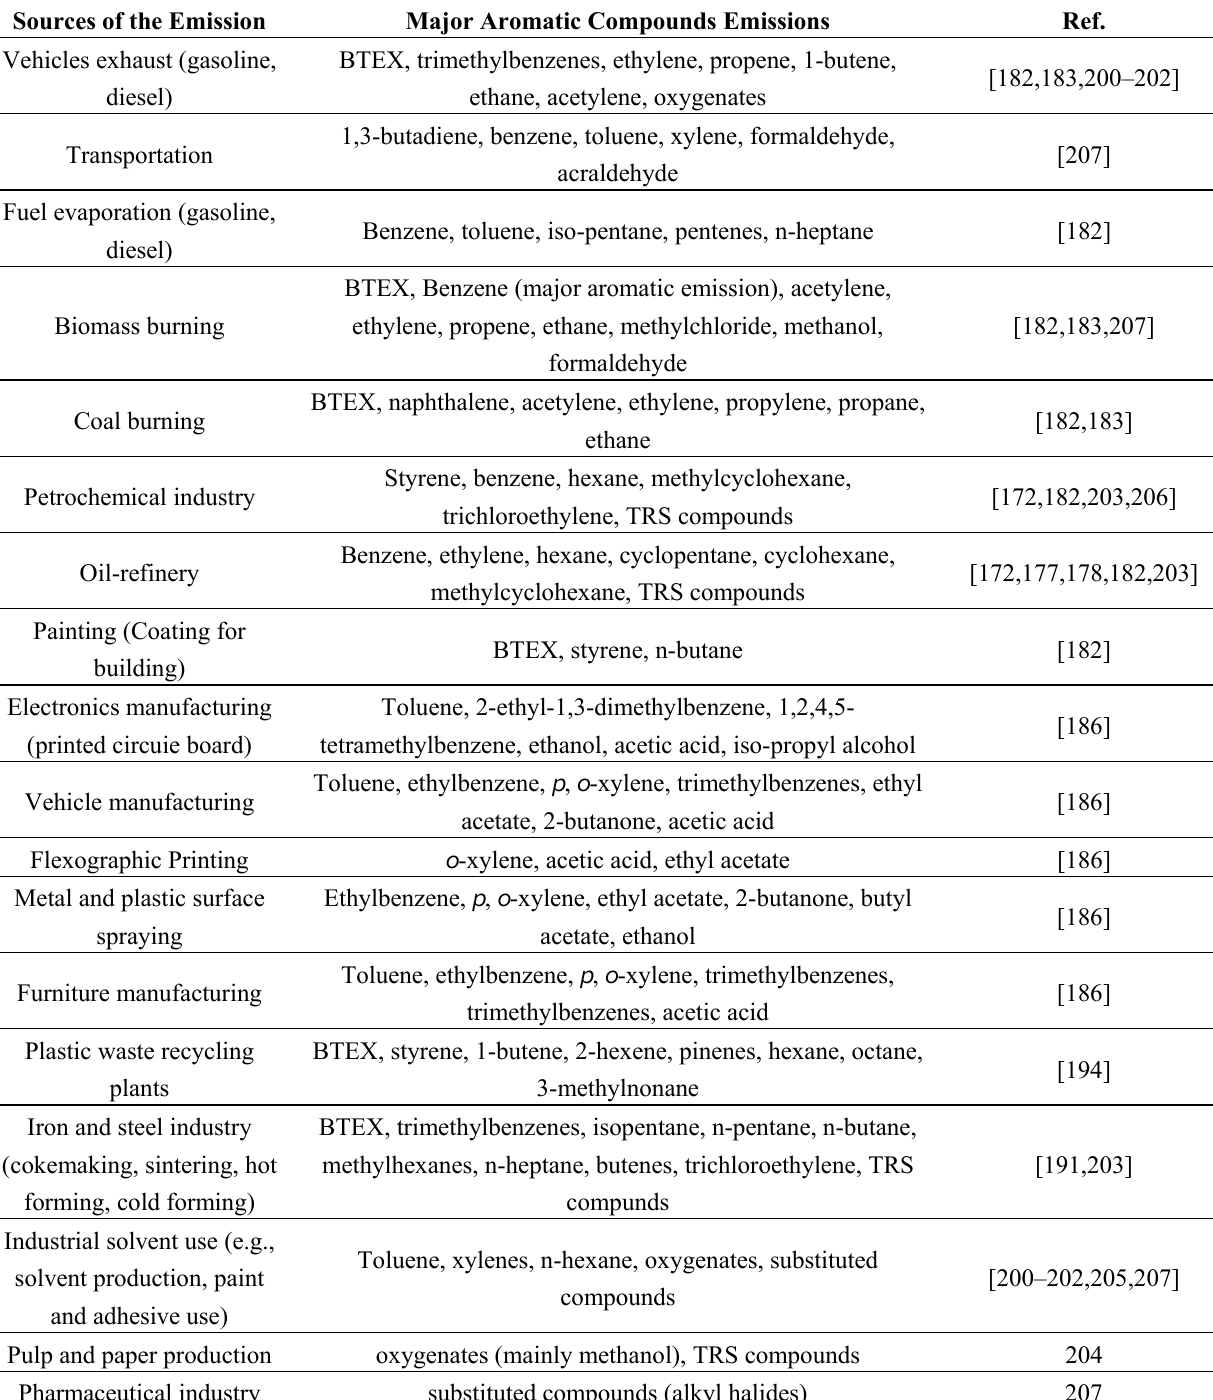
Table 6. Sources of the VOC